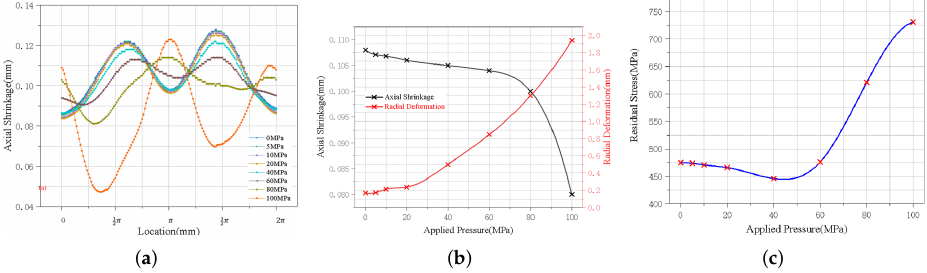
Figure 8. Stress and deformation at different applied pressures: ( a ) deformation trend, ( b ) average axial shrinkage and radial deformation, and ( c ) residual